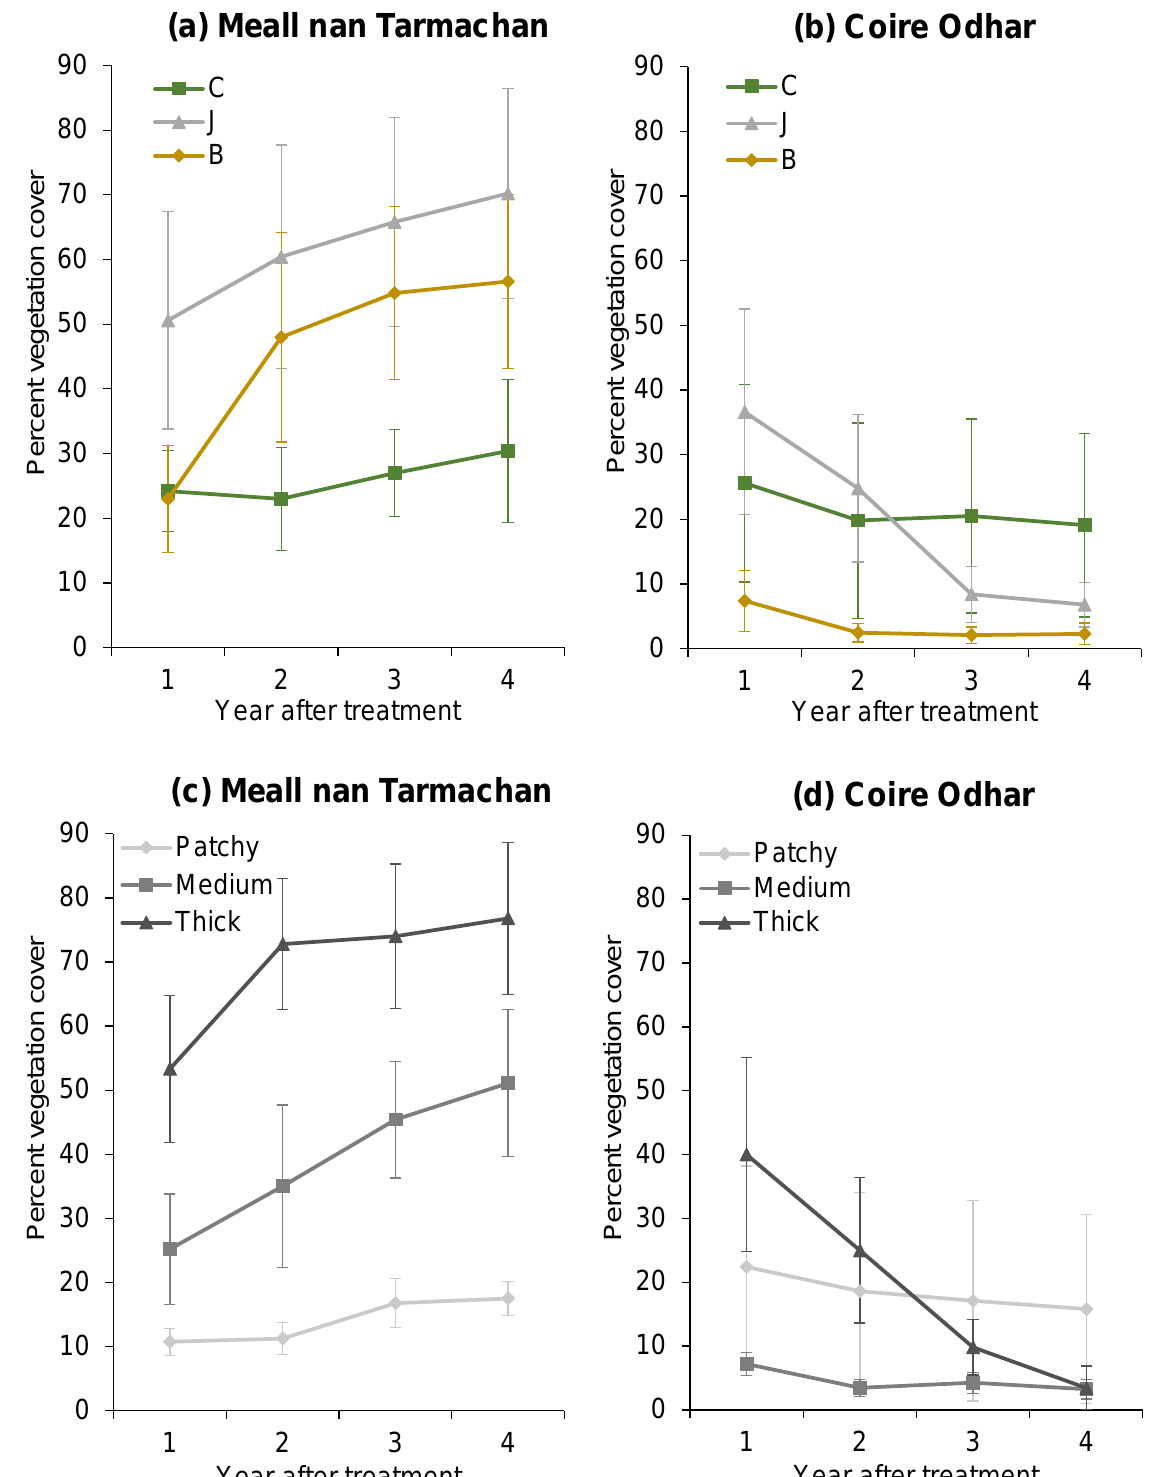
Figure 2. The mean percent vegetation cover in the four years following treatment for the plots at (a) Meall nan Tarmachan (MT) applied with three different netting treatments, (b) Coire Odhar (CO) applied with three different netting treatments, (c) Meall nan Tarmachan (MT) applied with three levels of brash cover* and (d) Coire Odhar (CO) applied with three levels of brash cover*. Error bars are ± 1 SE. C = Coir and heather brash; J = GeoJute and heather brash; B = brash only. *brash cover defined as patchy (<50 % cover), medium (50–85 %) and thick (>85